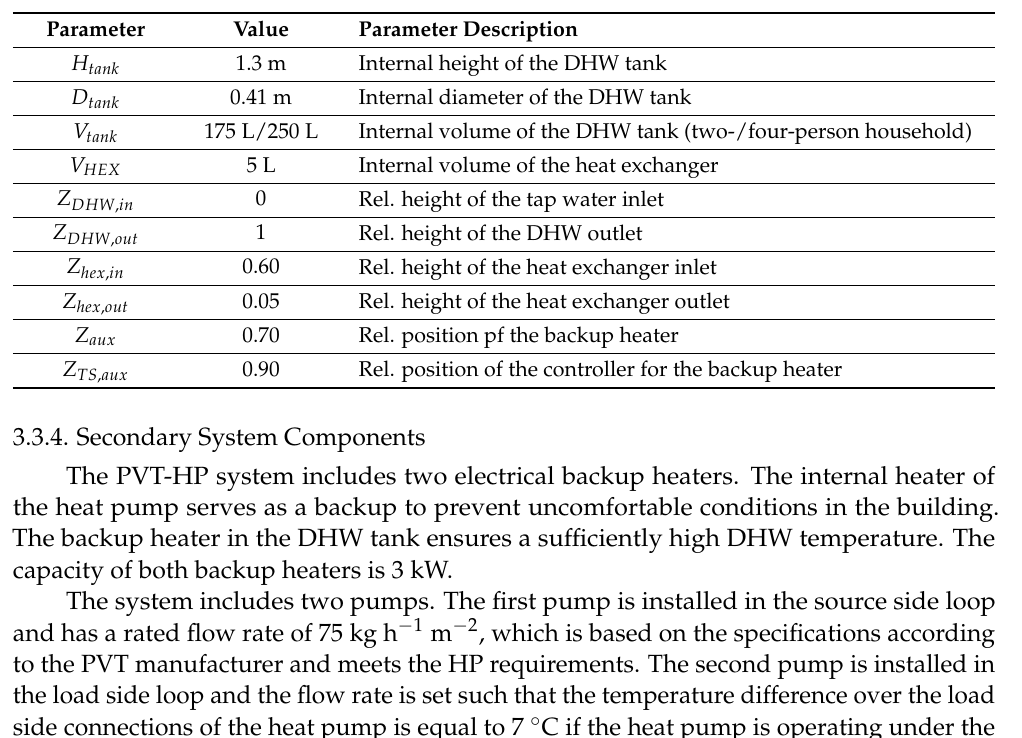
Table 11. Geometrical features of the DHW